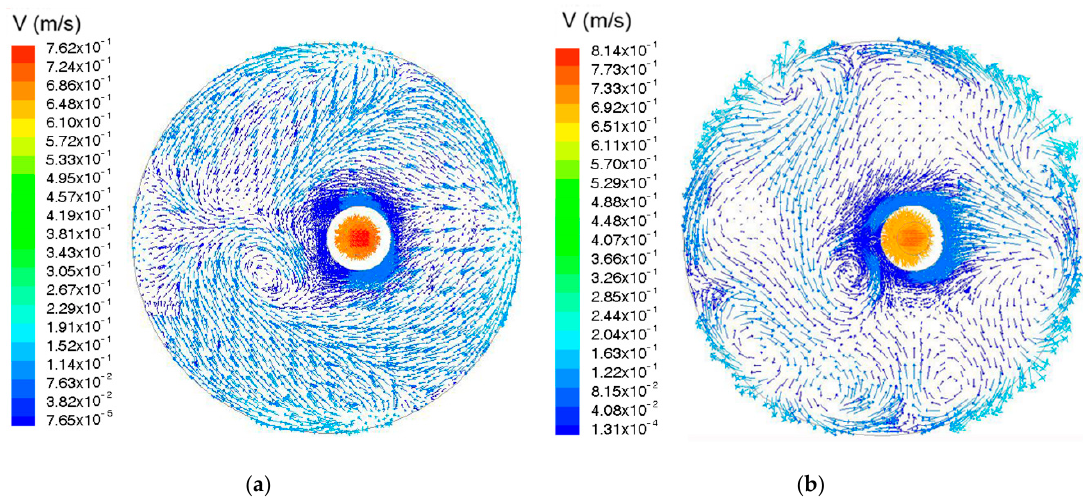
Figure 17. Velocity vector of steel-slag interface under the eccentric condition. ( a ) The original SEN; ( b ) The optimized swirling SEN.